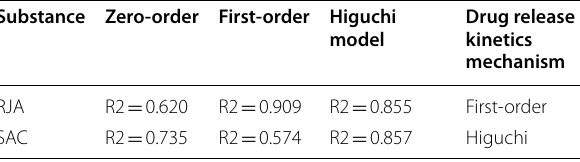
Table 4 Mathematical modeling and drug release kinetics of RJA and SAC‑containing Na alginate emulgel